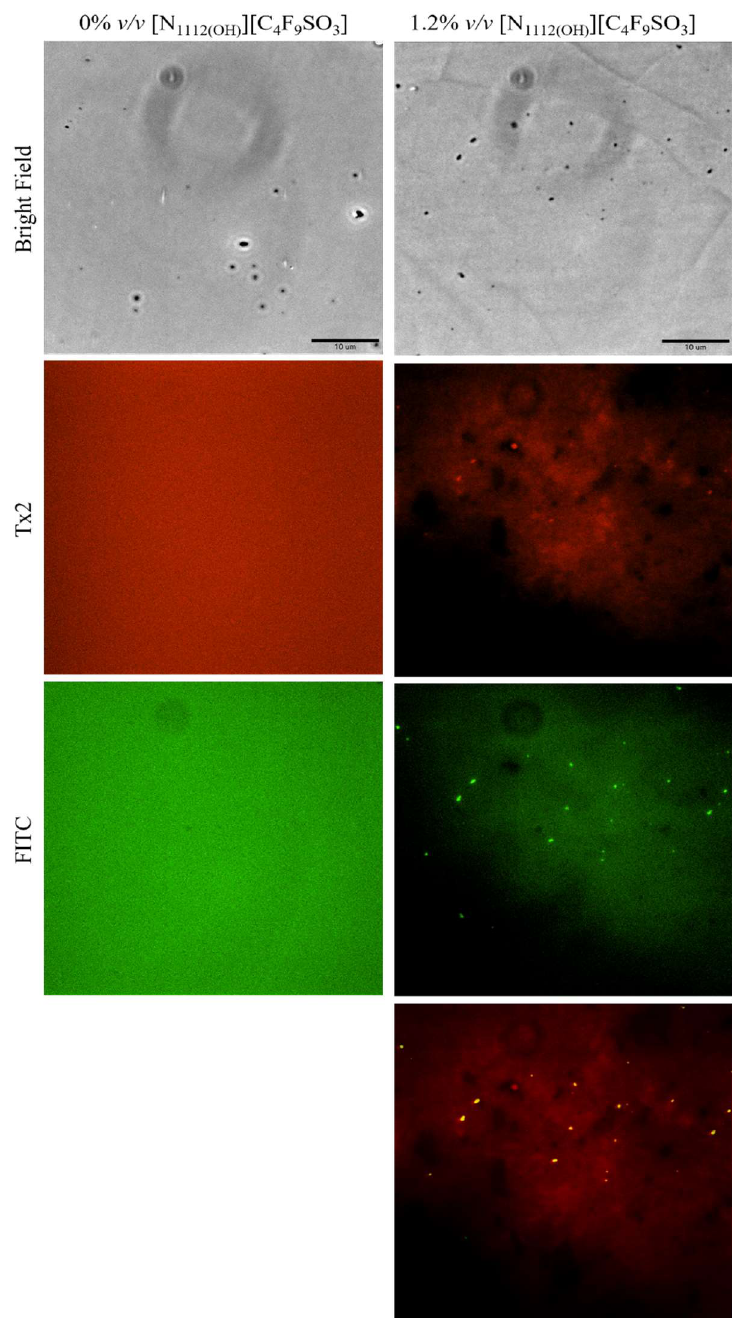
Figure 17. Fluorescence microscopy of Lys-Fluo + NR samples in the presence of 1.2% v / v [N 1112(OH) ][C 4 F 9 SO 3 ]. The last image corresponds to the superposition of the two images above. Scale bar represents 10 µm. Scale bar represents 10 µ